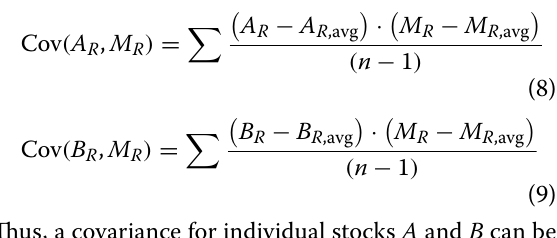
Table 3 Covariance matrix for two stocks